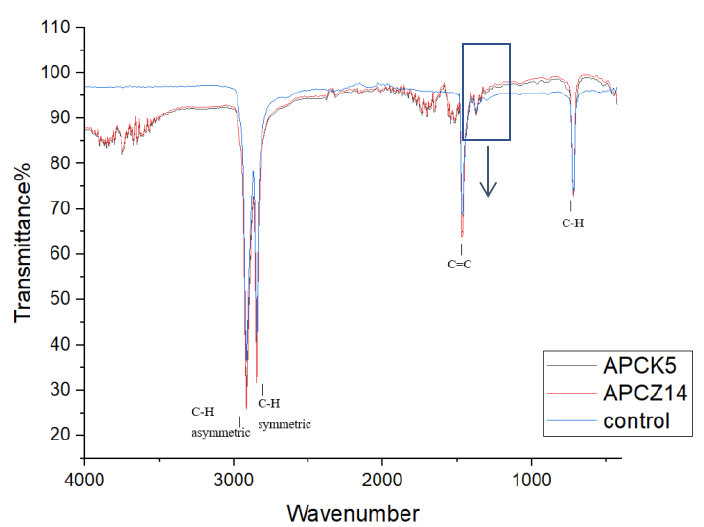
Figure 3. FTIR spectra of LDPE powder after incubation for 180 days with APCK5, APCZ14, and control.